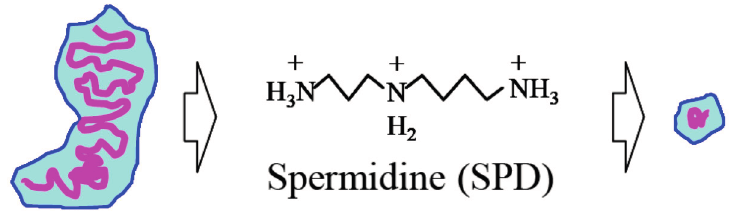
Figure 9. Coil-globule transition of DNA by SPD (Reprinted from